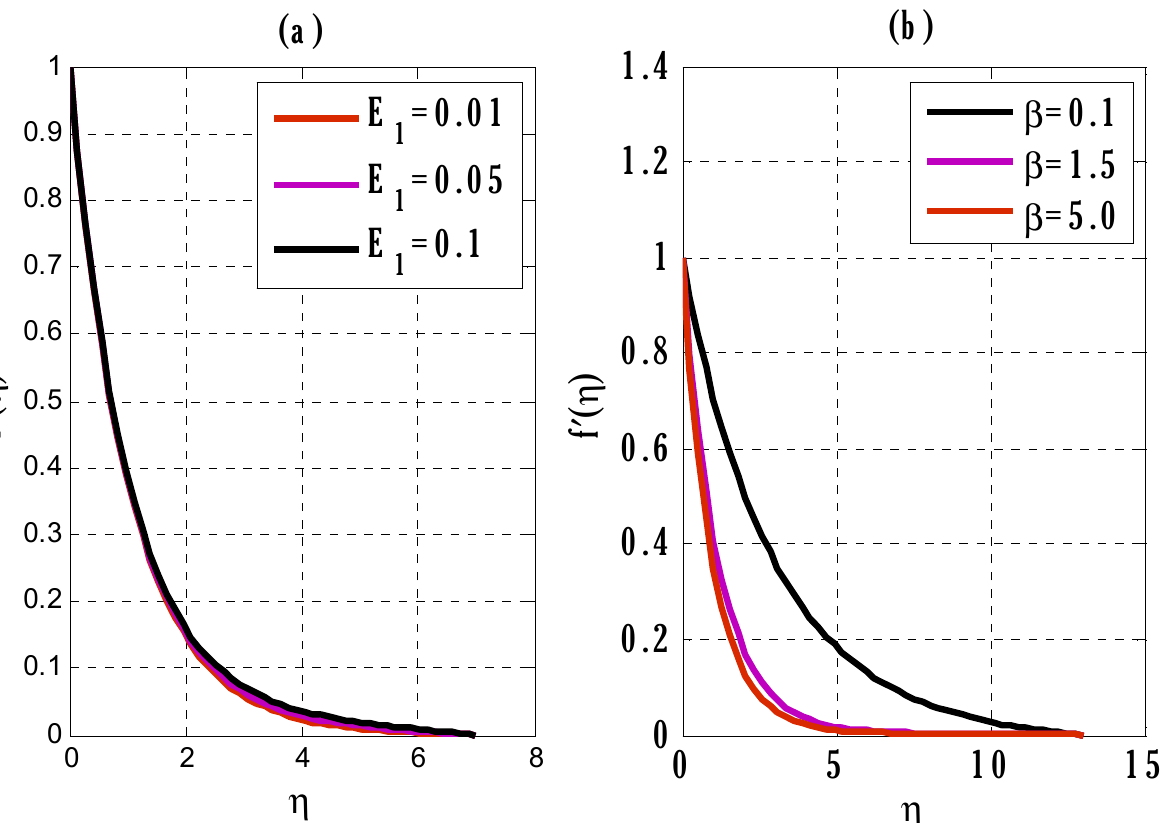
Figure 1. Variation of electric and Casson parameters on velocity profile using M = 0.1, λ = 0.1 ( a ) β = 3 ( b ) E 1 = (cid:2869)